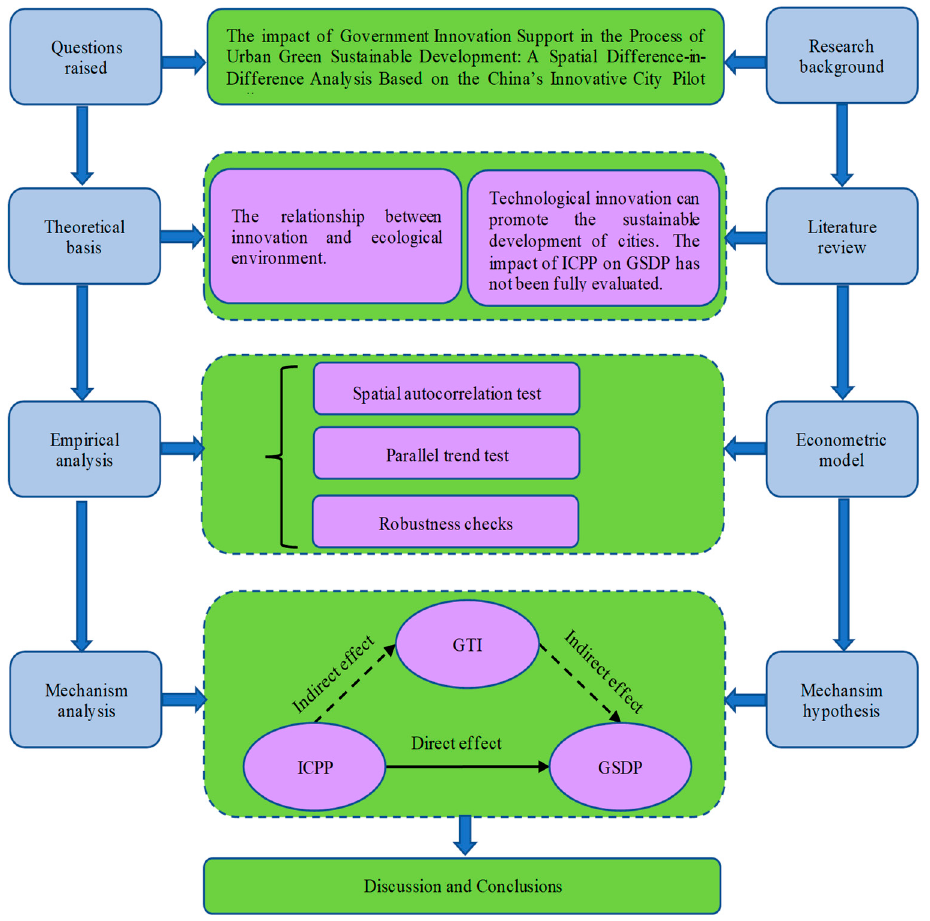
Figure 1. The framework and technical route of this study.